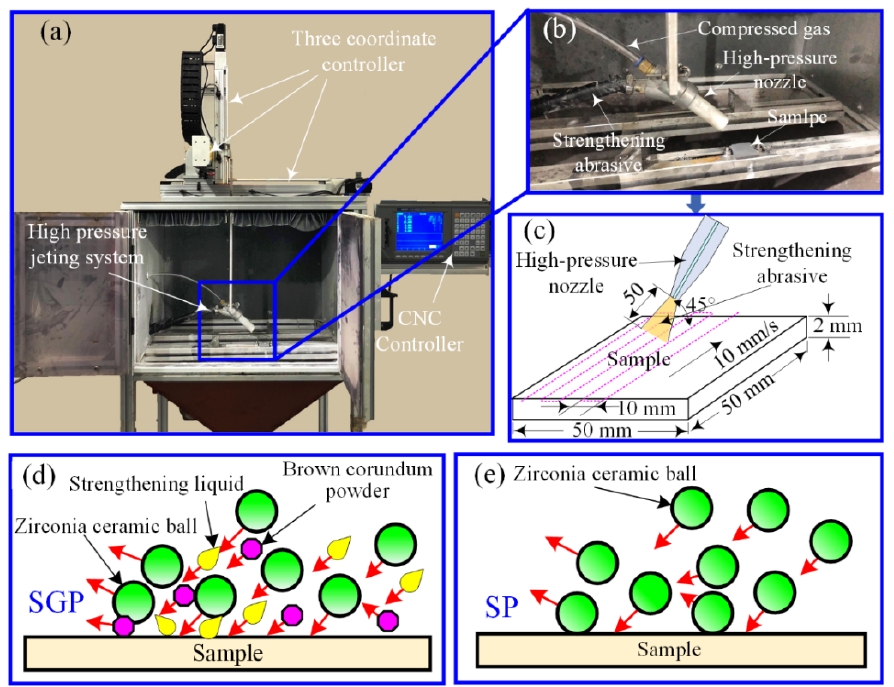
Table 3. The technological parameters for strengthening grinding processing.